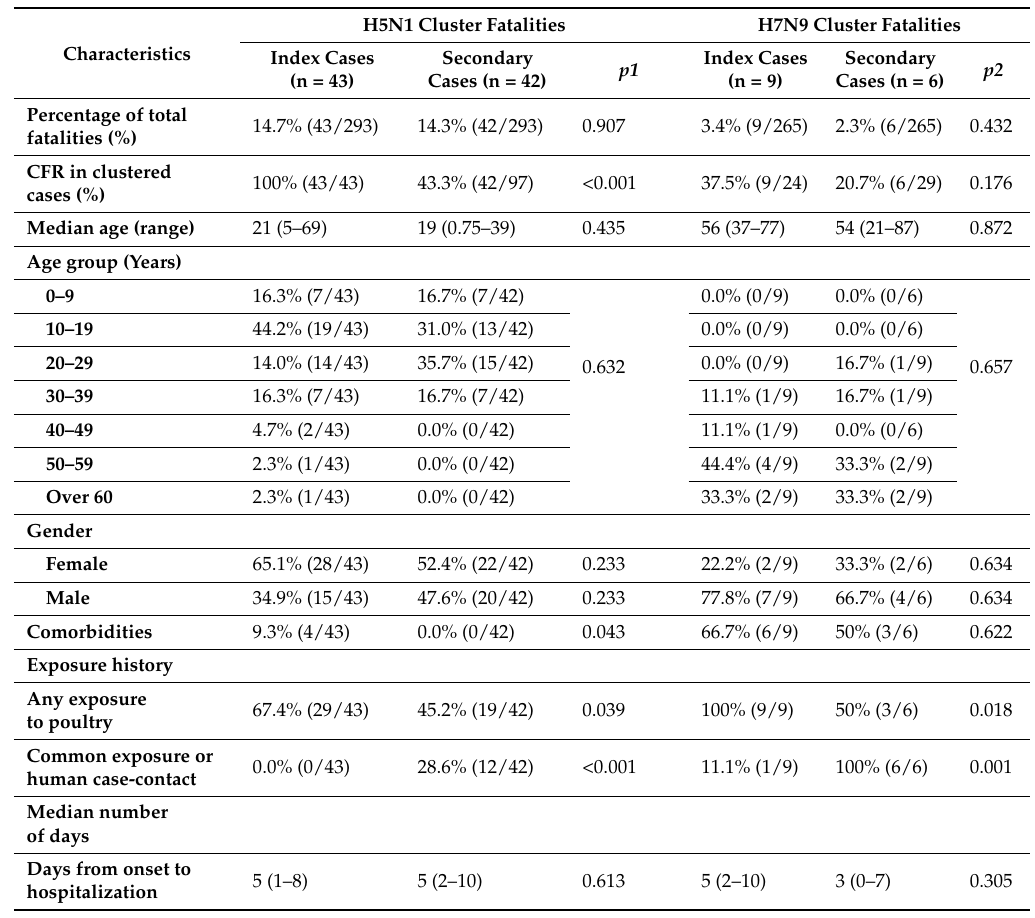
Table 3. Demographic characteristics of clustered H5N1 and H7N9 virus